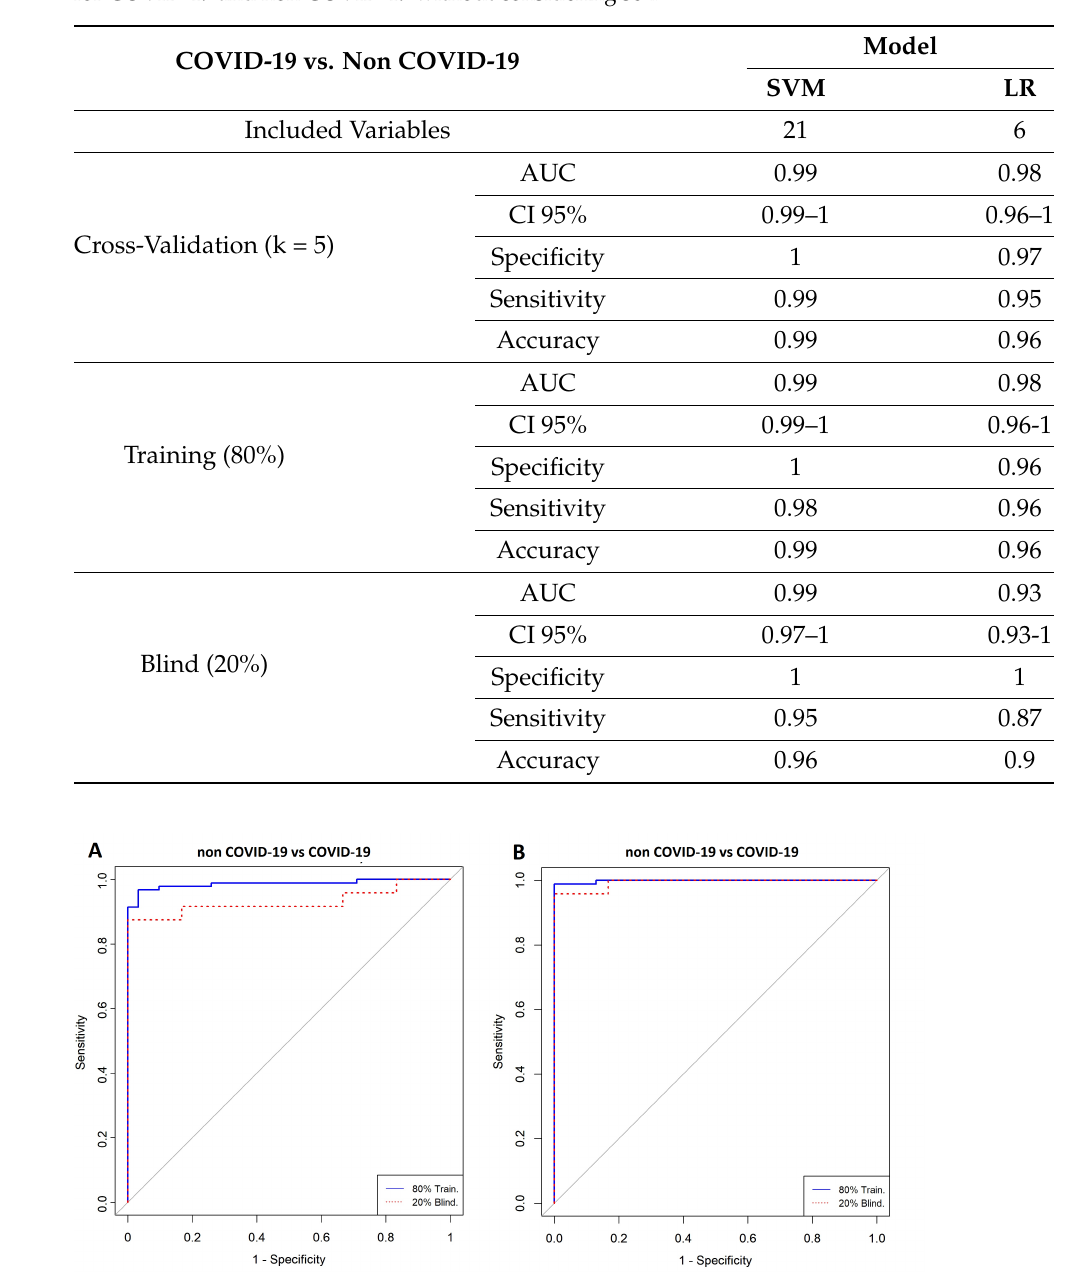
Table A1. Evaluation criteria for logistic regression model with all factors and support vector machine for COVID-19 and non COVID-19 without considering sex.